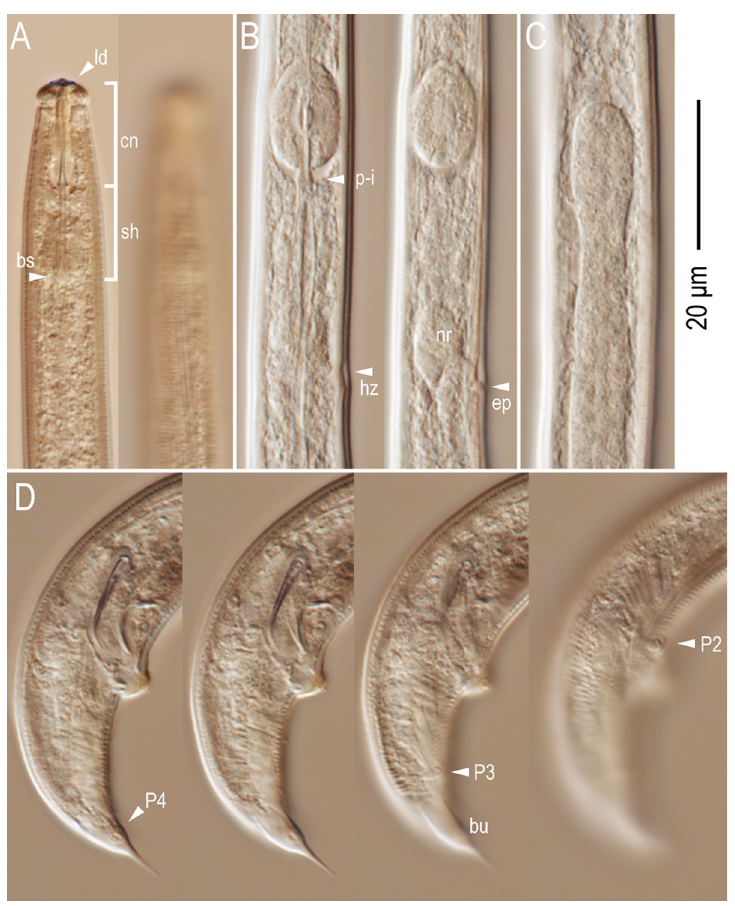
Fig 4. Light micrographs for male Bursaphelenchus suri n. sp. A: Lip and stylet region in two different focal planes (ld = labial disc; cn = stylet conus; sh = stylet shaft; bs = basal swelling); B: Pharyngeal part in two different focal planes (p-i = pharyngo-intestinal junction; hz = hemizonid; nr = nerve ring; ep = secretory-excretory pore); C: Anterior end of testes; D: Male tail in four different focal planes (P + number = genital papillae; bu = bursal flap). All subfigures are in right lateral view. Male . Body and gonadal structure are typical to the genus. Anterior end of testis out- stretched (8 out of 9 type specimens) or reflexed (1 out of 9). Spermatocytes arranged in multi- ple (3–5) rows. Spicules typical for the fungivorus group of the genus. Gubernaculum absent. Tail smoothly tapering in anterior 2/3, and distal 1/3 narrowing abruptly. Bursal flap conspicu- ous, an oval shape with a triangular projection at the posterior end. Three pairs of genital papillae present, but ventral precloacal papilla (P1) which is present in most other parasitaphe- lenchid nematodes not observed in light microscope, possibly vestigial. Female . Structure and position of reproductive tract typical to the genus. A pair of three- celled structures usually found in the genus was not confirmed, possibly because of material condition, but this region was somewhat sclerotized. Vulva without any flap apparatus. Post- uterine sac long, 6.3–9.7 vulval body diam. long, extending for almost half or more (47–73%) of vulva to anus distance. Tail slender, 5.6–10.7 anal body diam. long, elongate conoid in shape, smoothly tapering to pointed terminus. Morphometrics. Morphometric values are summarized in Table 1.